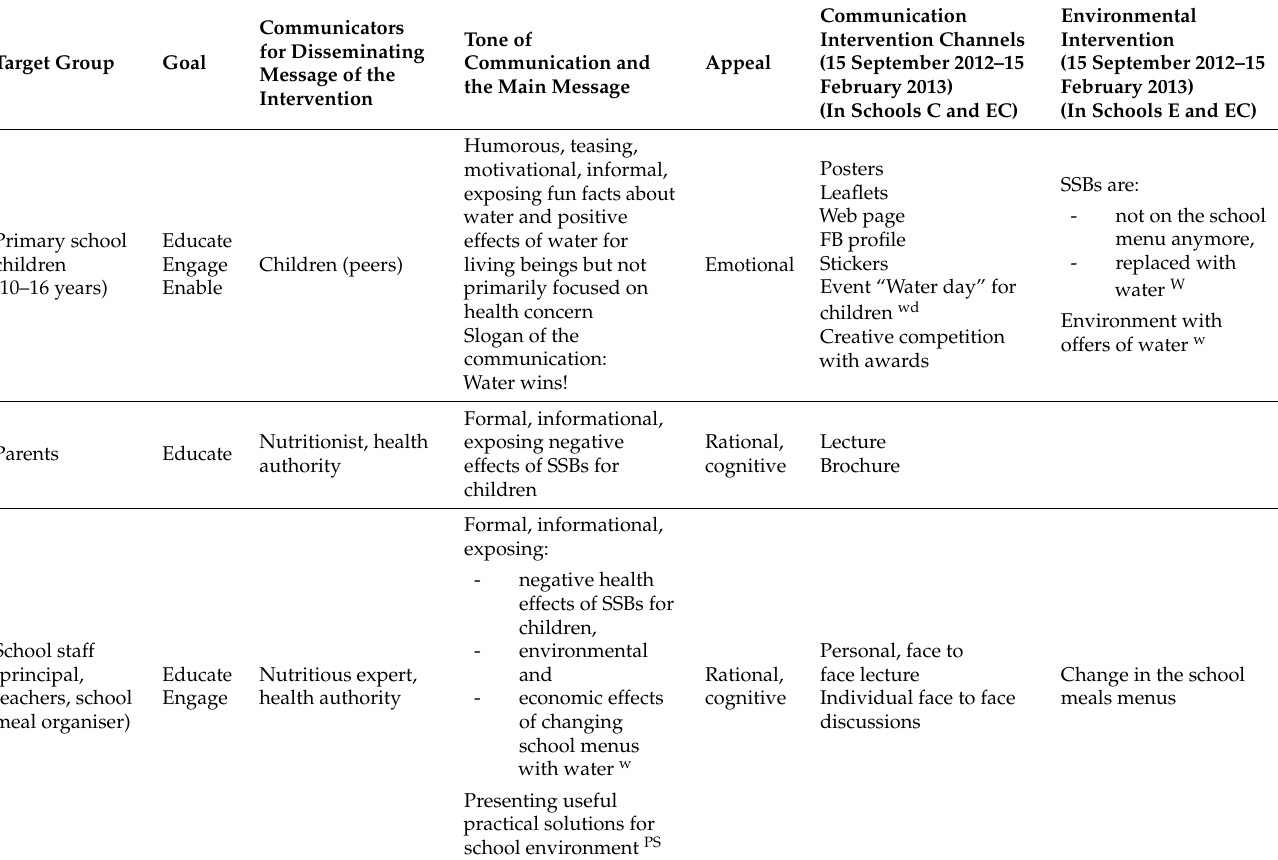
Table 1. Interventions according to the chosen target